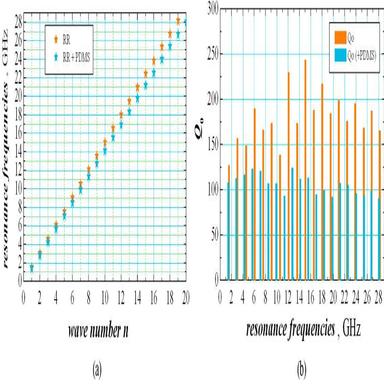
(a) Resonance curves of microstrip ring resonator on substrate ISOLA Astra MT 3.0 without and with covering PDMS sample according to the wavenumber and (b) corresponding unloaded Q factors.